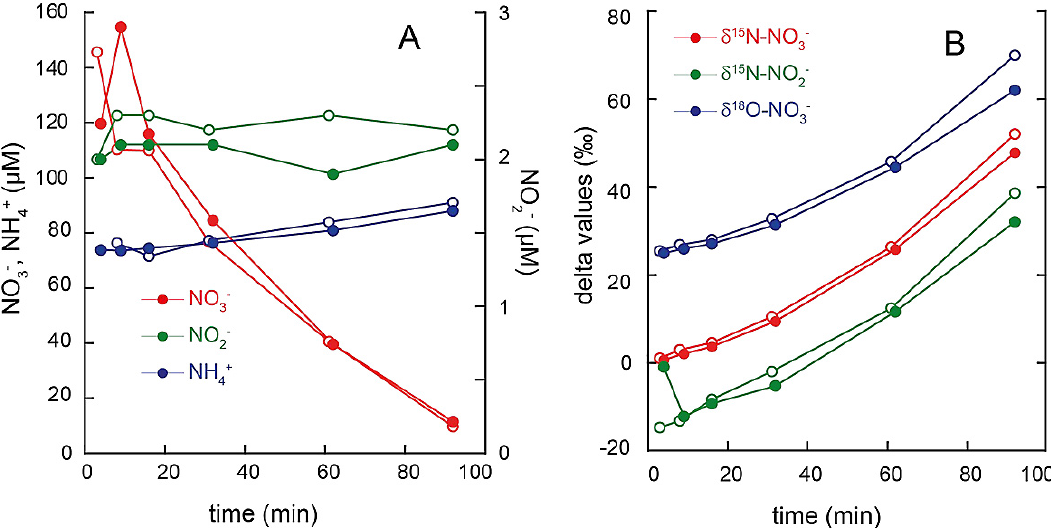
Fig. 3. Changes (A) in DIN concentration and (B) nitrate and nitrite isotopes over time in two parallel sediment incubations (open and filled symbols).